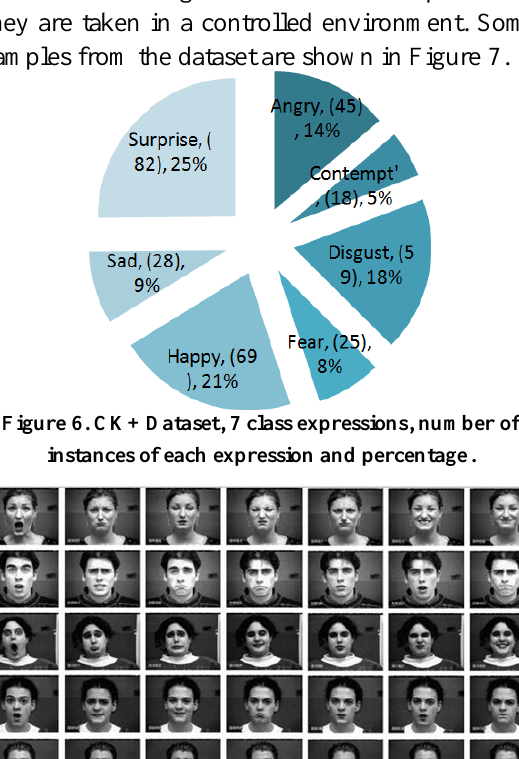
Figure 7. Cohn-Kanade (CK+) sample